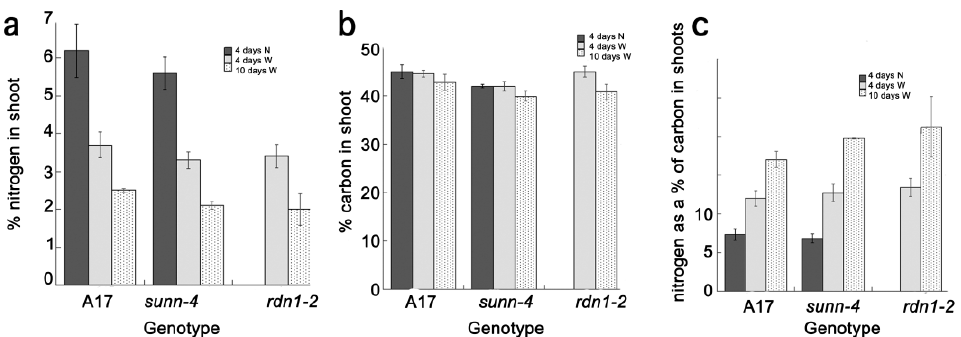
Figure 6. Carbon and nitrogen in shoots as a percentage of dry weight determined by 13 C and 15 N isotope analysis of organic solids. An equal amount of tissue was pooled from three plants for each genotype and condition at the day of inoculation, dried, and analysis performed in triplicate ( a ). Mean percent nitrogen in leaves from plants in which the first roots was watered with 10 mM NH 4 NO 3 for four days from Figure 3 (black bars-data for rdn1-2 not available) with water for four days from Figure 5 (grey bars) and with water for 10 days from Figure 5 (dotted bars) ( b ). Mean percent carbon from the same material and ( c ) C/N ratio of plants in (a) and